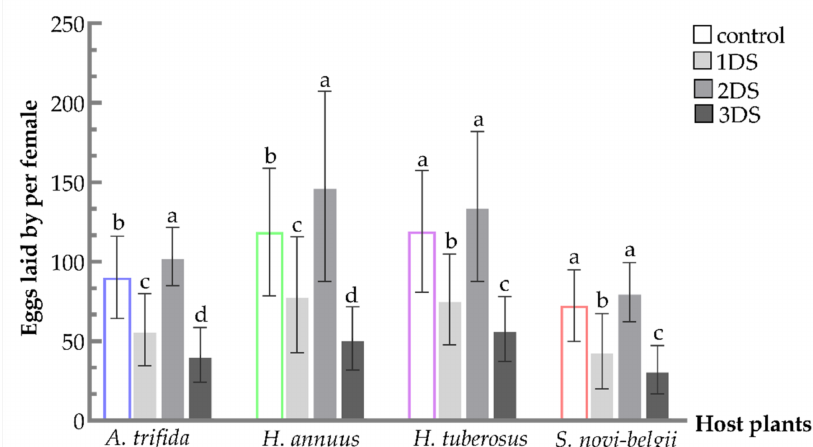
Figure 5. Eggs laid by per female of C. marmorata suffering from food deprivation on four host plants. Control: the group offered host leaflets continuously without food deprivation; 1DS: the group subjected to 1 day’s starvation; 2DS: the group subjected to 2 days’ starvation; and 3DS: the group subjected to 3 days’ starvation. Values are the mean ± SD. Different lowercase letters “a, b, c, d” in one species of host plants indicate significant differences (one-way analysis of variance followed by Duncan’s test, p <